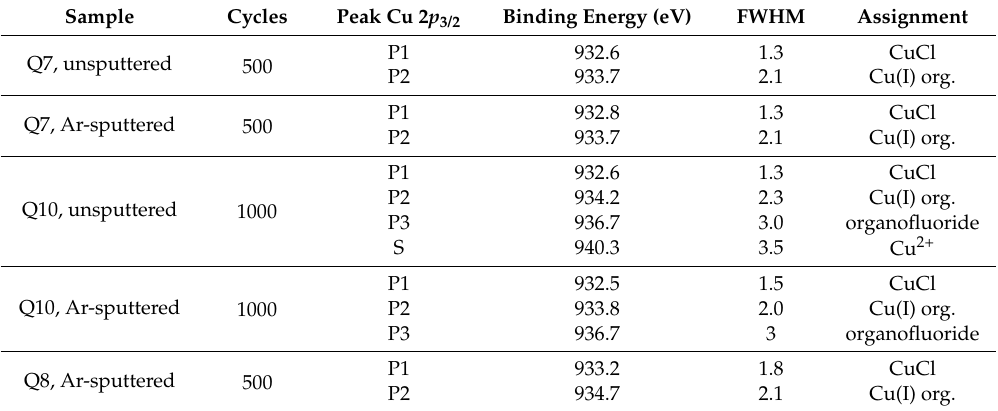
Table 5. Peak parameters for Cu 2p XPS.